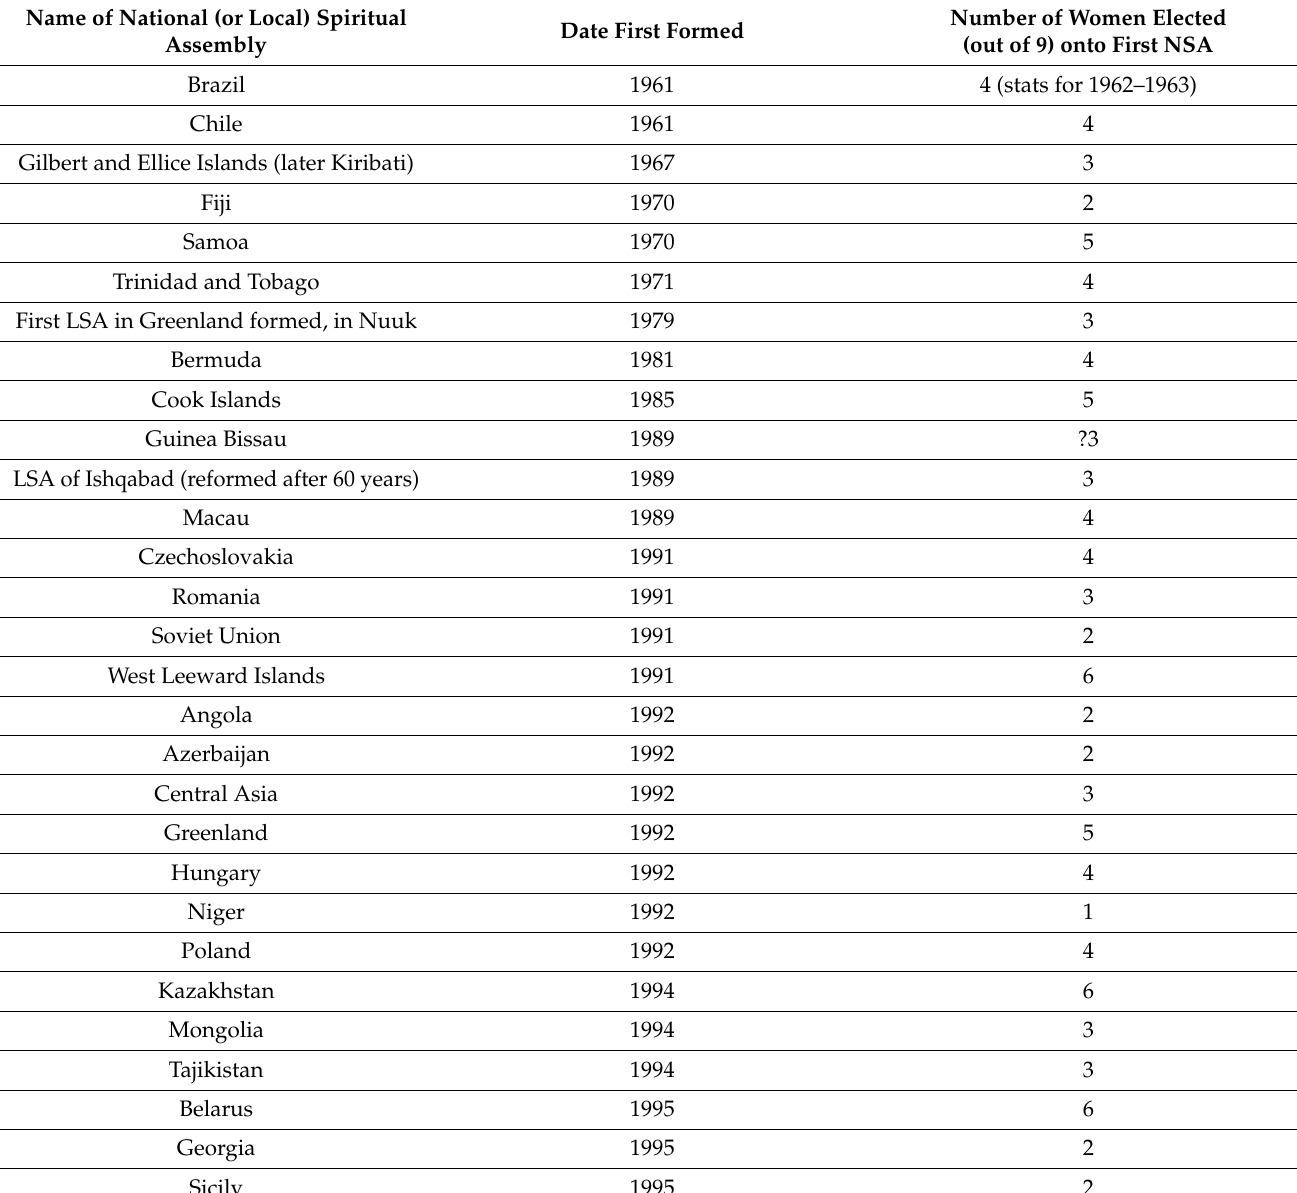
Table 3. National (or local) Spiritual Assembly throughout the